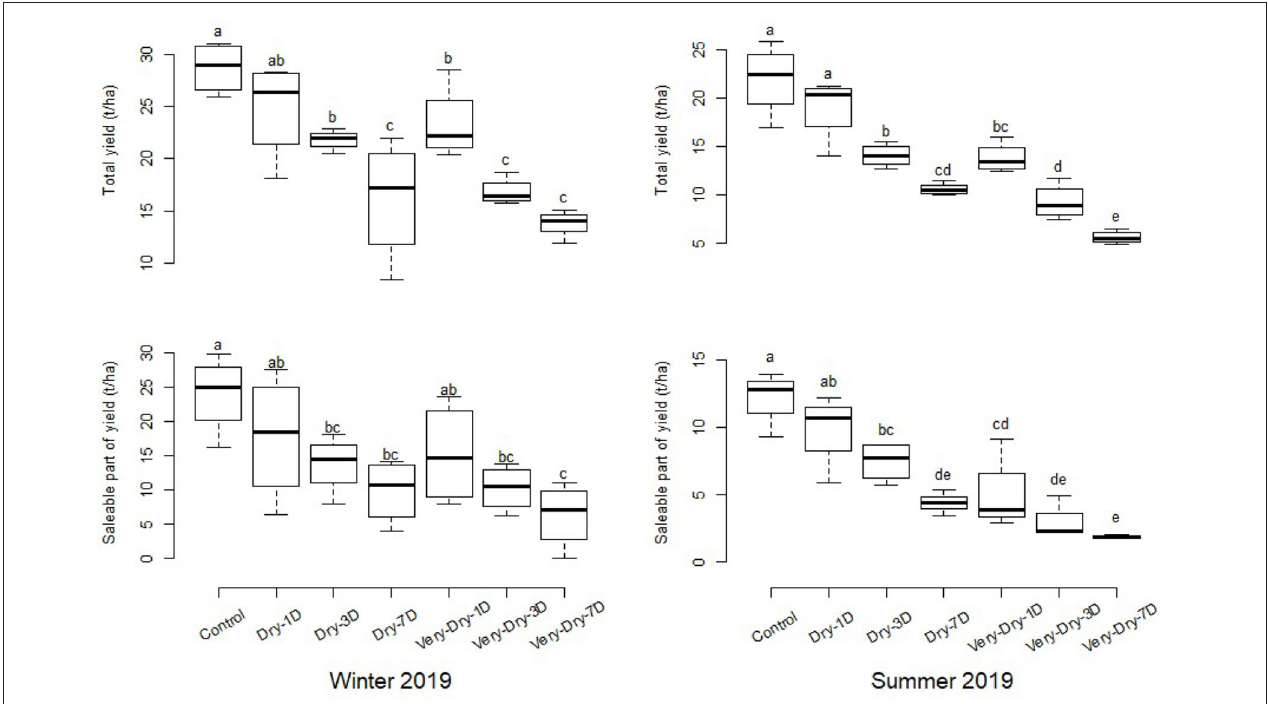
FIGURE 7 | Total yield and fraction of saleable yield for the two experiments in winter and summer of 2019. The error bars represent the standard deviation around the mean for the four replicates of a same treatment. The letters on the boxplots corresponding to each treatment represent the different classes according to their difference. These classes are obtained from the LSD test and allow to assess the level of significance between treatments and controls at a threshold p < 0.05.